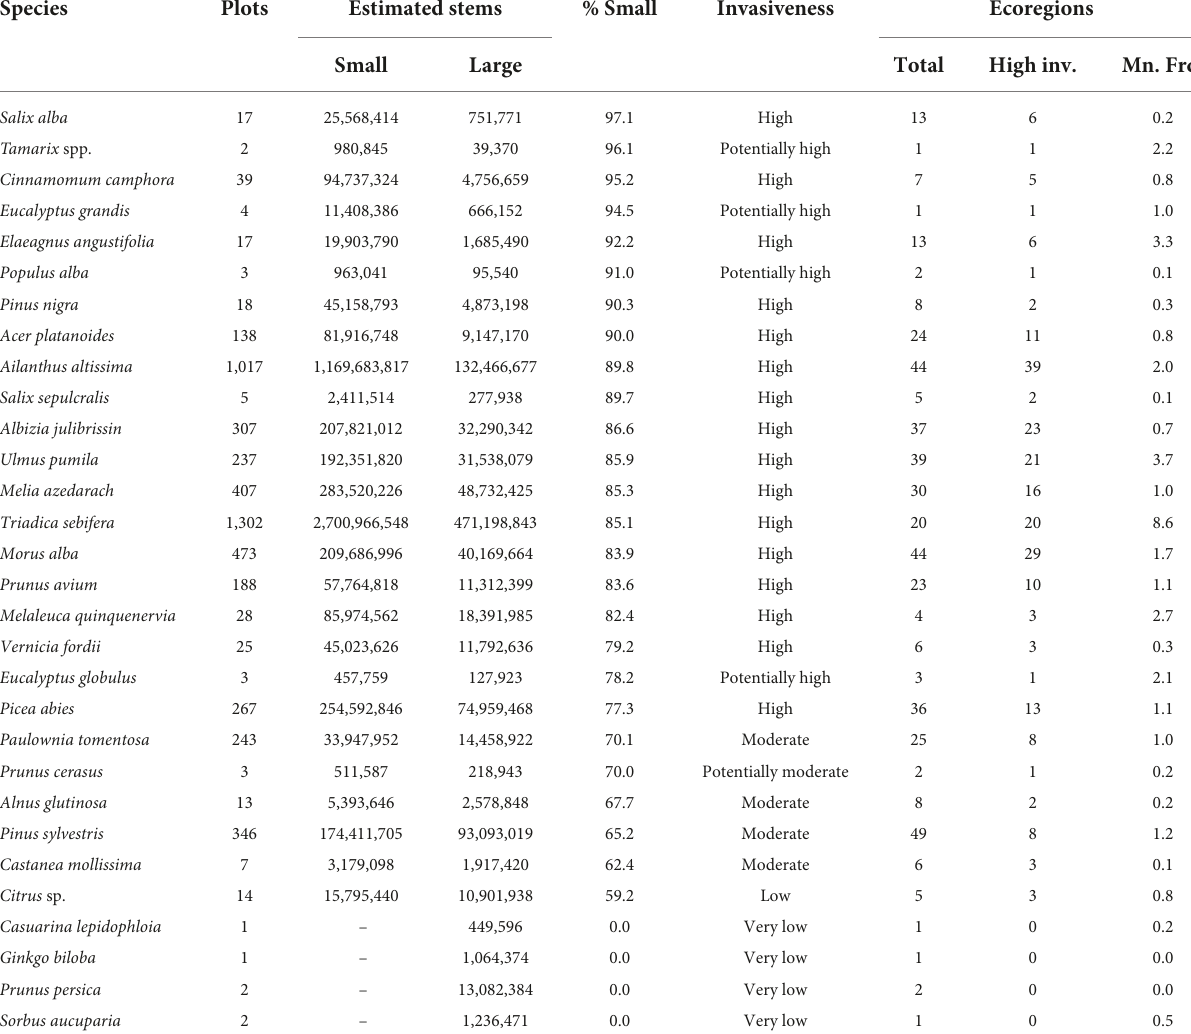
TABLE 1 Thirty non-native tree species detected by the Forest Inventory and Analysis (FIA) program in the conterminous United States and Alaska, along with the number of plots on which each was inventoried; the estimated number of small and large stems based on the FIA sample design; the percent of all trees within the small tree size class; the overall potential invasiveness assigned to the species based on its proportion of smaller trees, and the total number of ecoregion sections on which each species was detected, the number of ecoregion sections where each species is highly invasive, and the mean frequency (percent of plots) on which the species occurs across the ecoregions in which it is present. Species Plots Estimated stems % Small Invasiveness Ecoregions Small Large Total High inv. Mn. Frq.